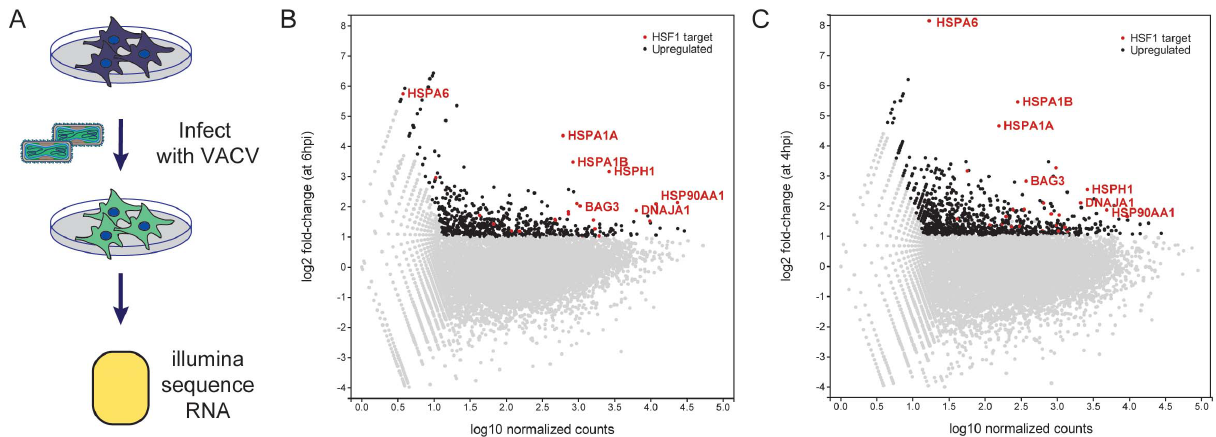
Figure 3. Host mRNA transcripts upregulated during VACV infection. (A) Schematic of RNASeq Experiment. (B) Dots represent the change in expression of genes from 0 to 6 hpi (x-axis) and the average number of sequencing reads that align to each gene in both timepoints (y-axis). Genes with a fold change greater than 2 and more than 20 counts at 6 hpi are considered upregulated (black). HSF1-regulated genes upregulated during VACV infection are labeled in red (a subset is labeled with gene names). (C) Same analysis as in (B) using the WTA-A dataset at 4 hpi from Yang et